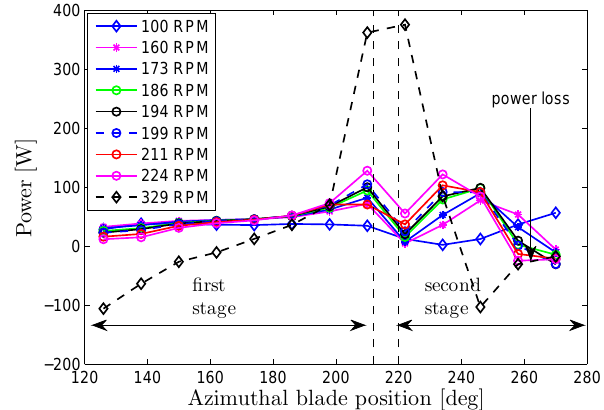
Figure 8. Azimuthal variation of power extraction per blade in the 0.53 kW turbine at η max and ω max = 199.1 RPM ( Q = 46 lps and H = 1.337 m)